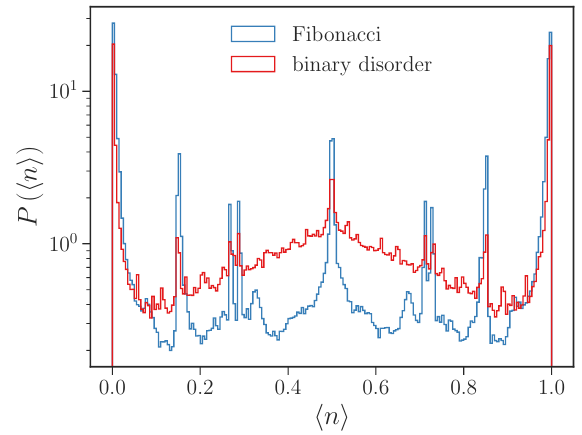
Figure 7: Comparison of Fibonacci and random binary disorder (shuffle) density distributions, for the system of L = 22 sites in the MBL regime at h =